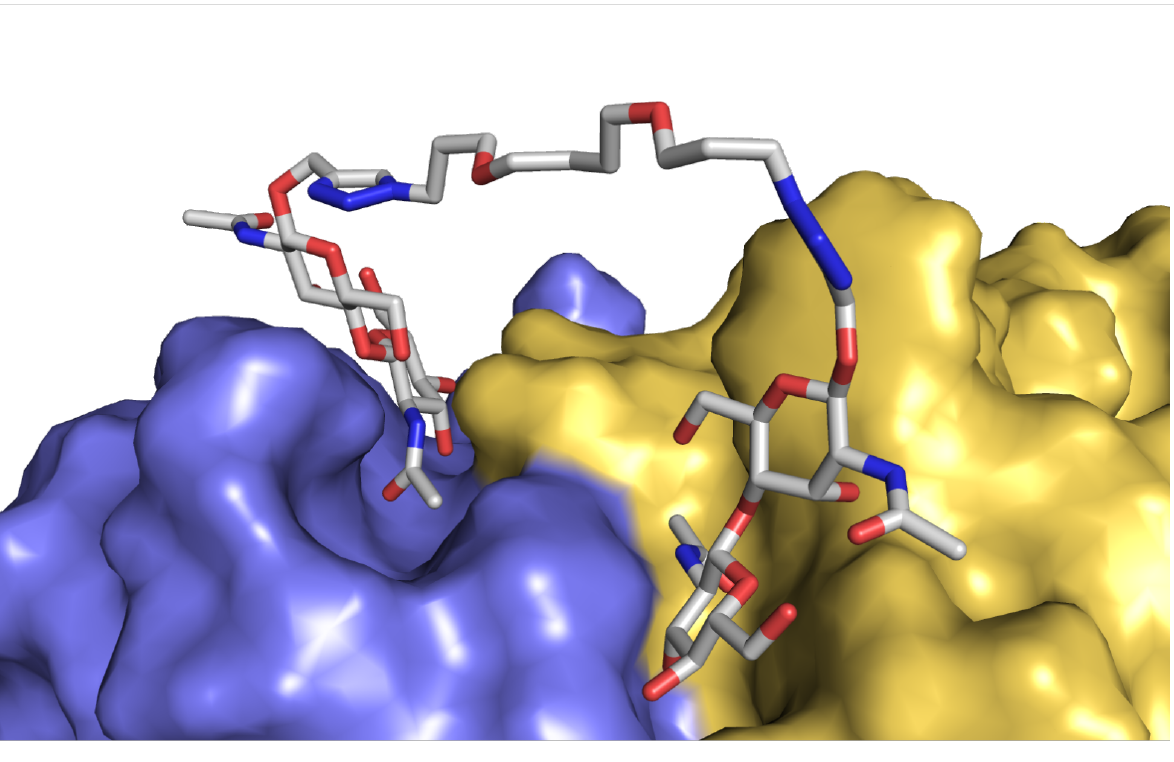
Figure 3: Molecular model of divalent ligand C4 with its two chitobiose moieties occupying two adjacent binding sites of WGA. The linker is conforma- tionally largely unrestricted and can adopt several low-energy conformations. WGA chain 1 is colored yellow, chain 2 is